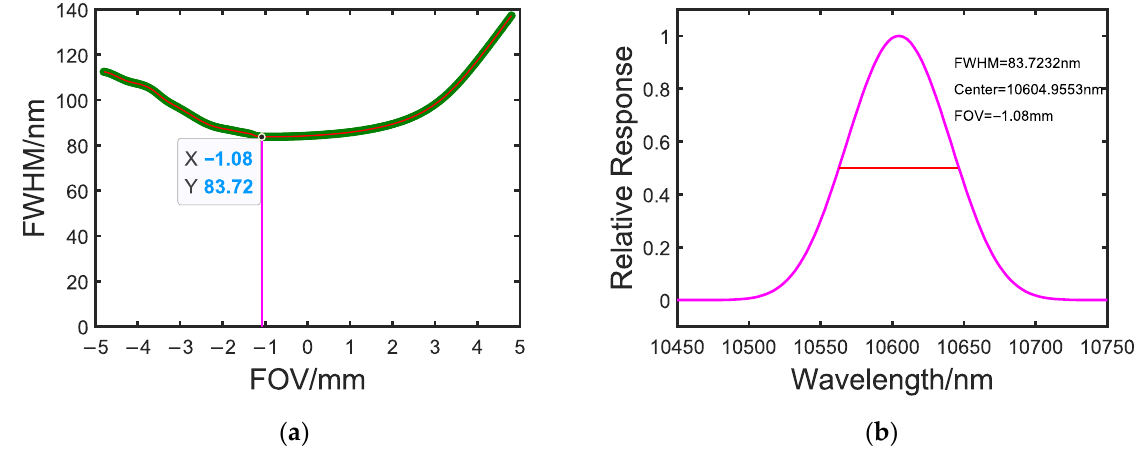
Figure 12. Simulation of the inclined slit image at 123 K. ( a ) the FWHM of the slit image; ( b ) the discrete sampling curve of the slit image.